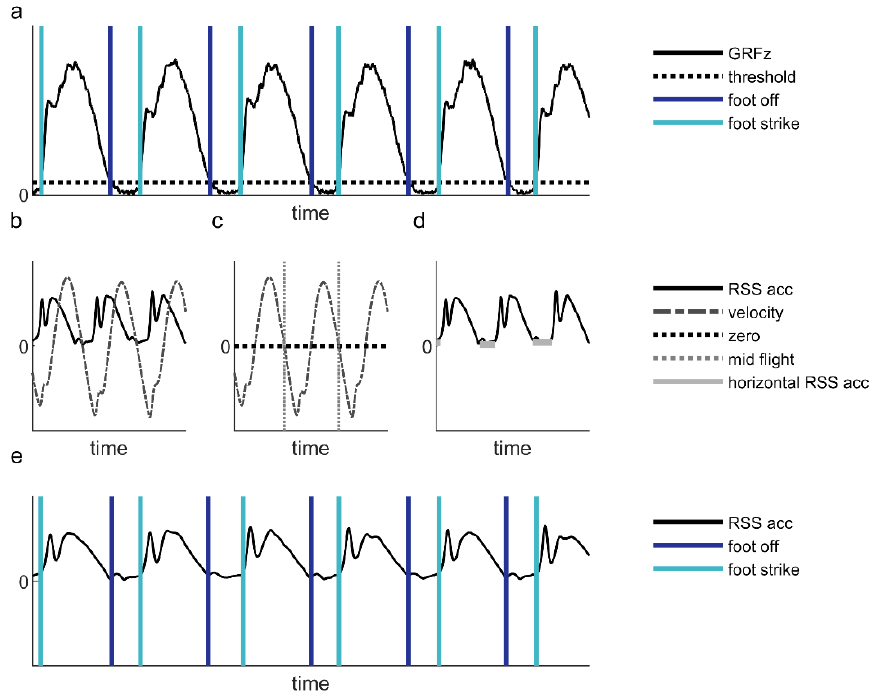
Figure 3. Example of representative data and an overview of the event detection. ( a ) The vertical ground reaction force (GRFz), the threshold (horizontal dotted line) and the instants of foot off and foot strike (vertical blue lines). ( b ) The root sum square of the acceleration data (RSS acc, solid black line) and the velocity (dashed grey line) during one second of running. ( c ) The velocity and its negative zero crossings (mid-flight, grey dotted vertical lines). ( d ) The root sum square of the acceleration data and the width of the horizontal sections (grey horizontal lines) around each mid-flight. ( e ) The root sum square of the acceleration data (RSS acc, solid black line) during two seconds of running. The vertical blue lines indicate instants of foot off and foot strike.